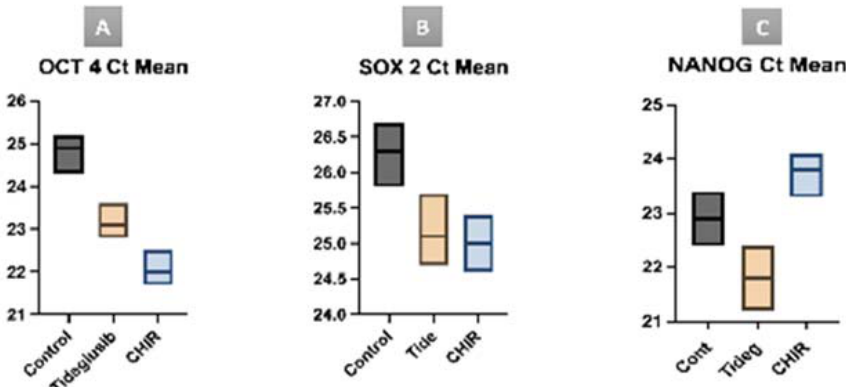
Figure 9. Graph presentation of the Ct mean of the different gene expression. ( A ) Ct mean OCT 4 gene expresses in higher number of cycles in control group than in tidesglub group and CHIR group. ( B ) Ct mean SOX 2 gene in higher number of cycles in control group than in tidesglub group and CHIR group. ( C ) Ct mean NANOG gene in higher number of cycles in control group than in tidesglub group and CHIR group.